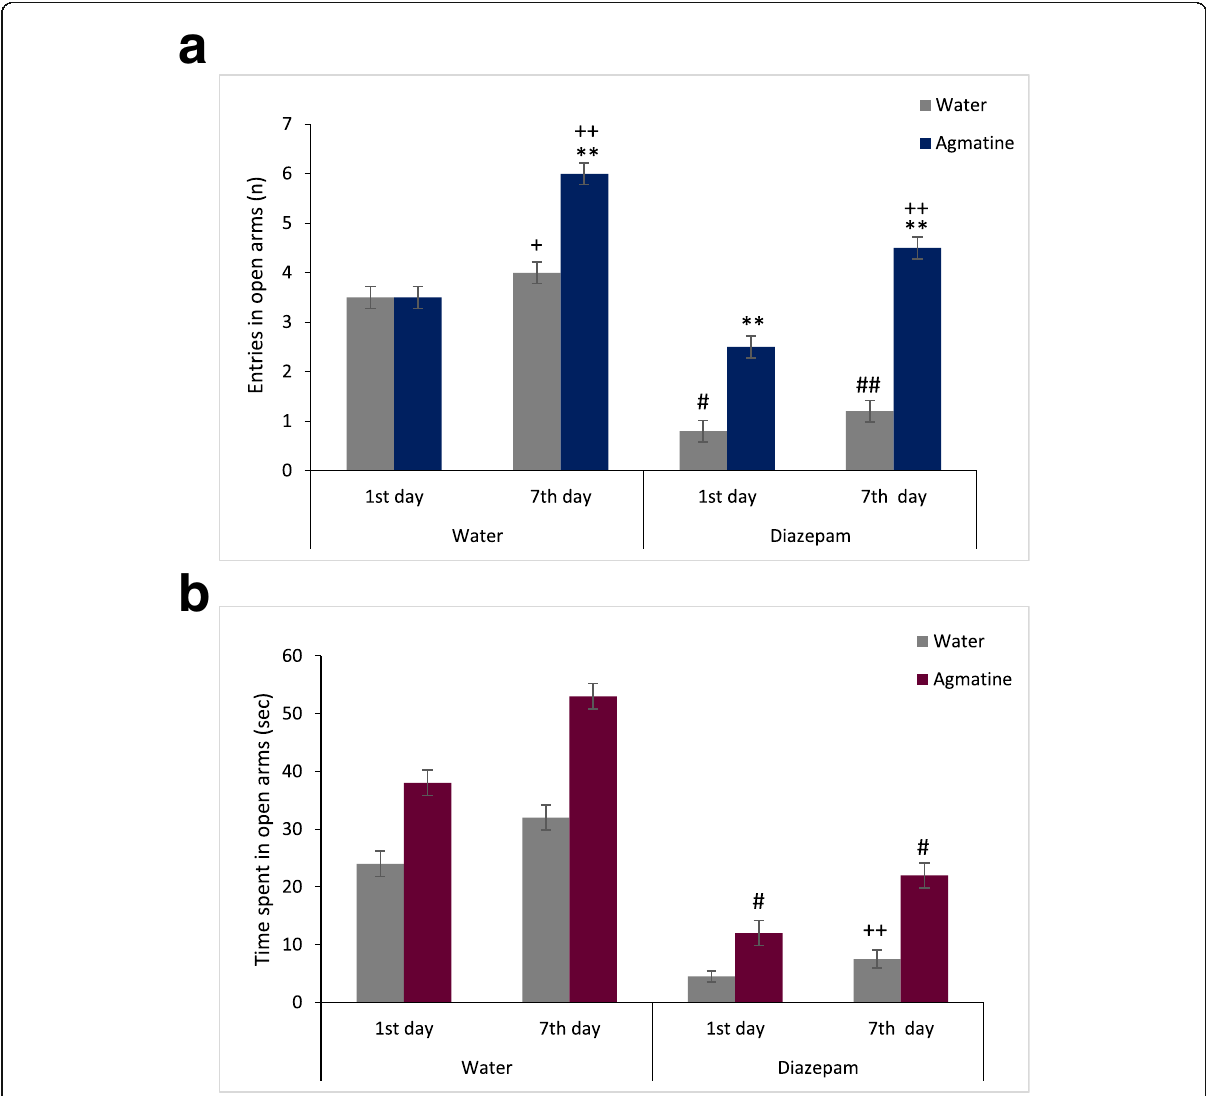
Fig. 3 a Elevated plus maze test (entries in open arms): Values are expressed as means ± SD (n = 12). Significant differences by Newman-Keuls test: ** p < 0.01, * p < 0.05 from control group to agmatine-treated groups. ++ p < 0.01, + p < 0.05 from the 1st day administration of water and agmatine. ## p < 0.01, # p < 0.05 from water-pretreated animals to respective withdrawal animals following II-way ANOVA. b Elevated plus maze test (time spent in open arms): Values are expressed as means ± SD (n = 12). Significant differences by Newman-Keuls test: ** p < 0.01, * p < 0.05 from control group to agmatine-treated groups. ++ p < 0.01, + p < 0.05 from the 1st day administration of water and agmatine. ## p < 0.01, # p < 0.05 from water-pretreated animals to respective withdrawal animals following II-way